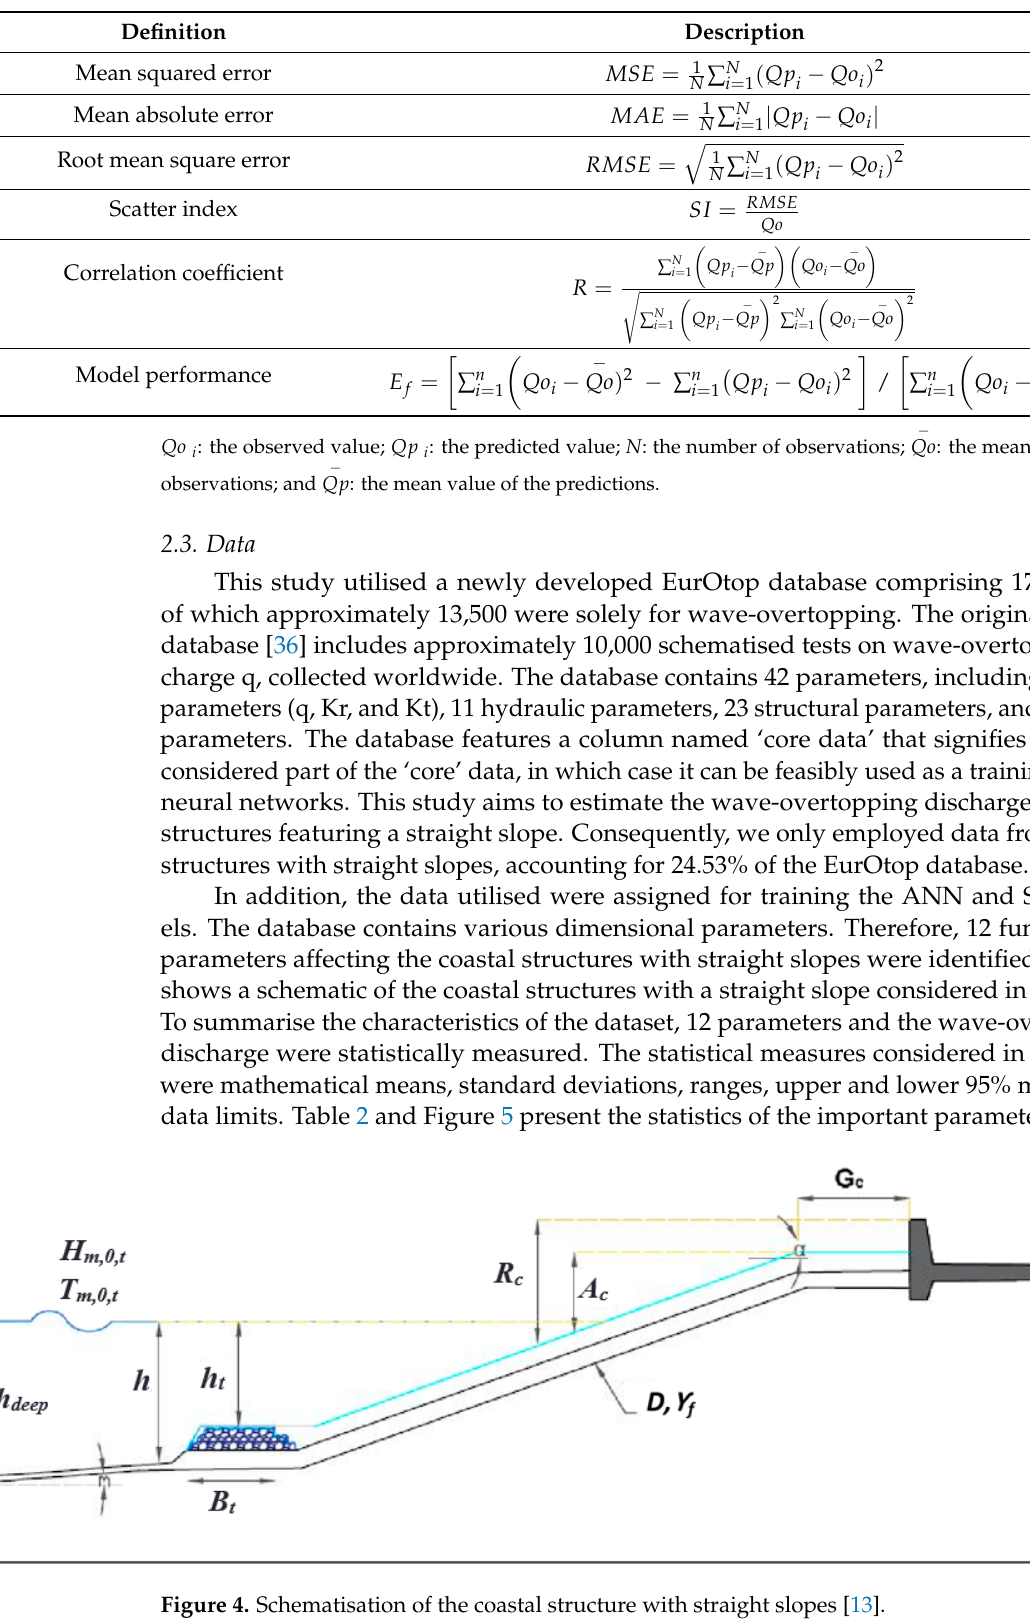
Figure 4. Schematisation of the coastal structure with straight slopes [13].